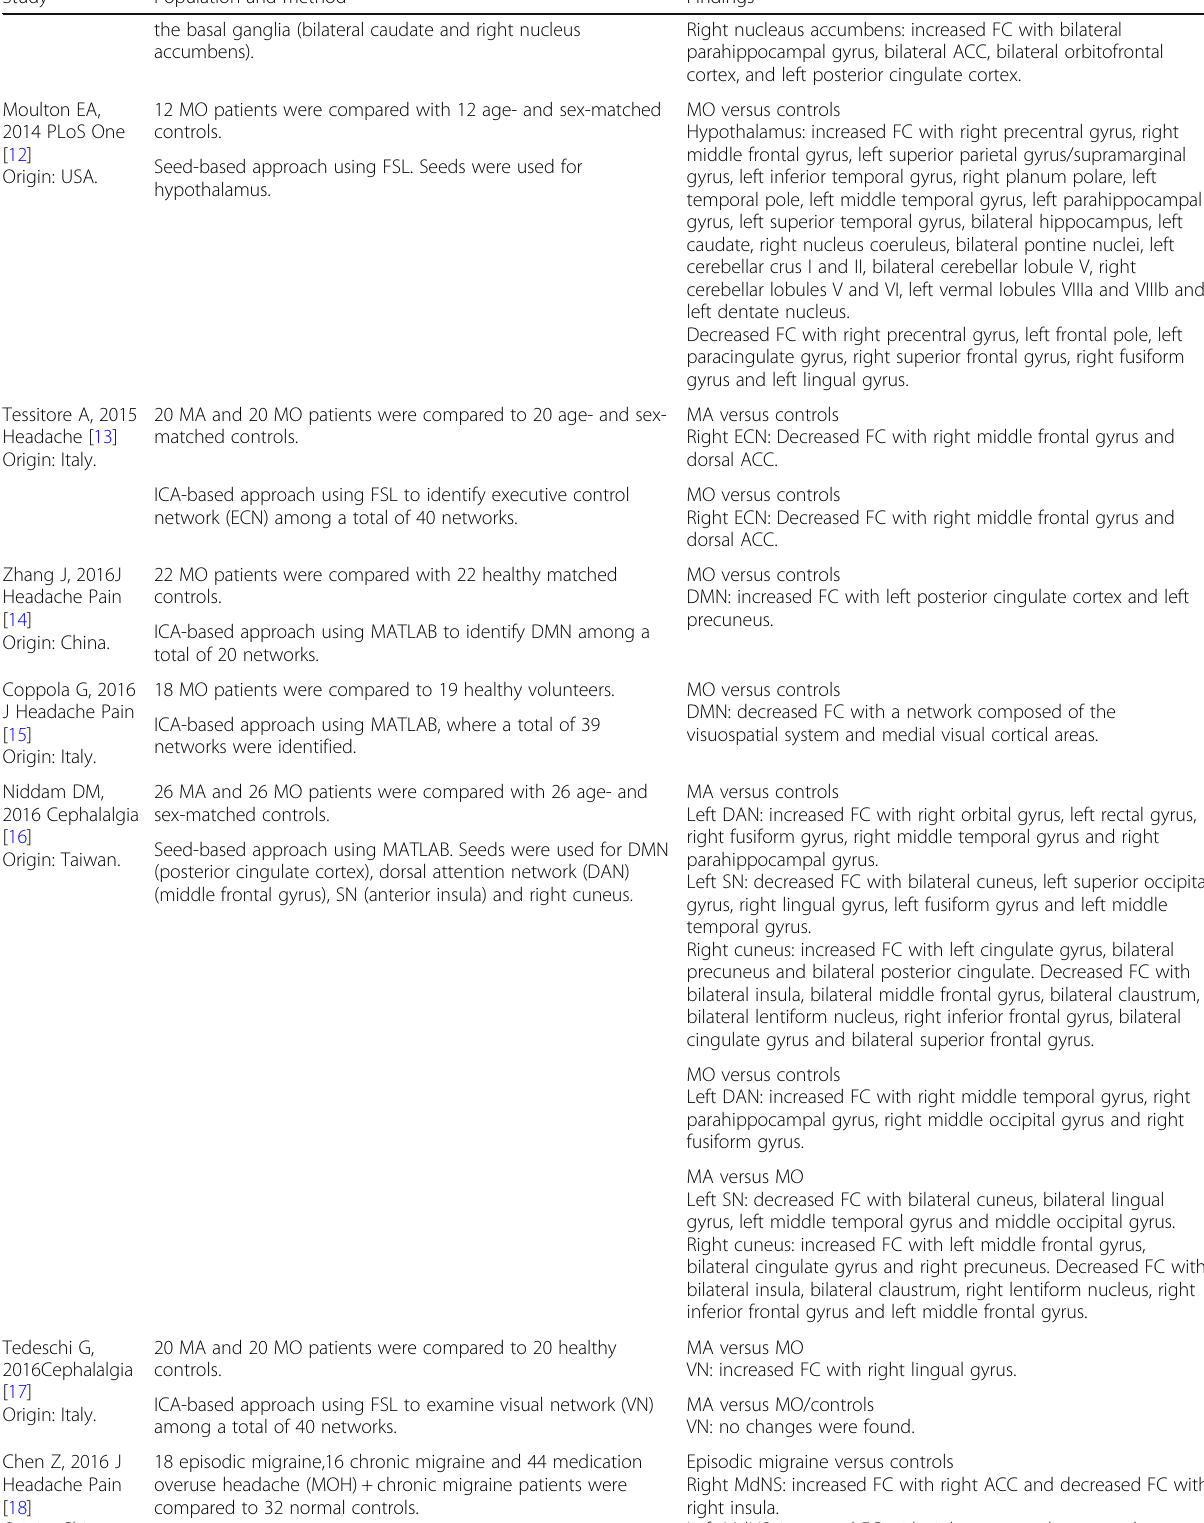
Table 1 Functional connectivity MRI during the interictal phase of migraine compared with non-migraine controls (Continued) Study Population and method Findings cortex.the basal ganglia (bilateral caudate and right nucleus accumbens). gyrus.Seed-based approach using FSL. Seeds were used for hypothalamus.